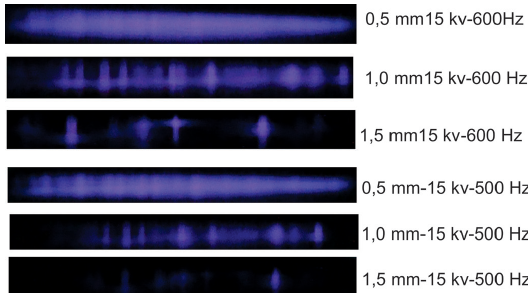
Figure 4. Visible Optical emission intensity resulting from atmospheric DBD at 600 and 500 Hz